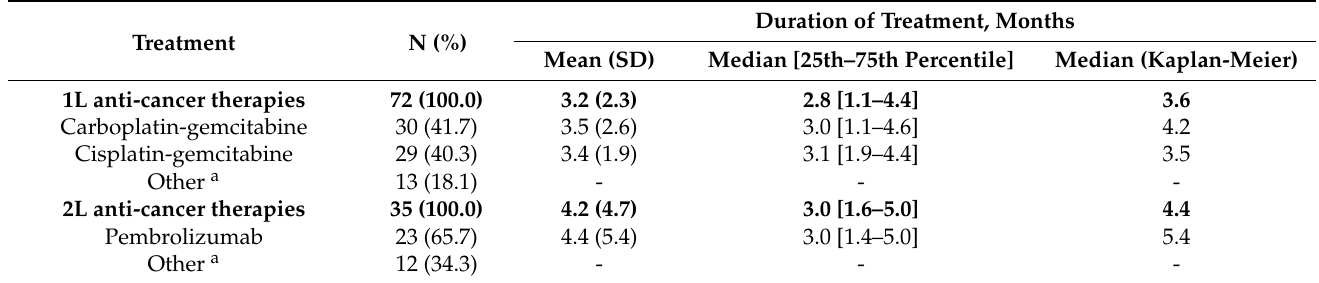
Table 3. Types of treatments and duration of therapy among patients with de novo